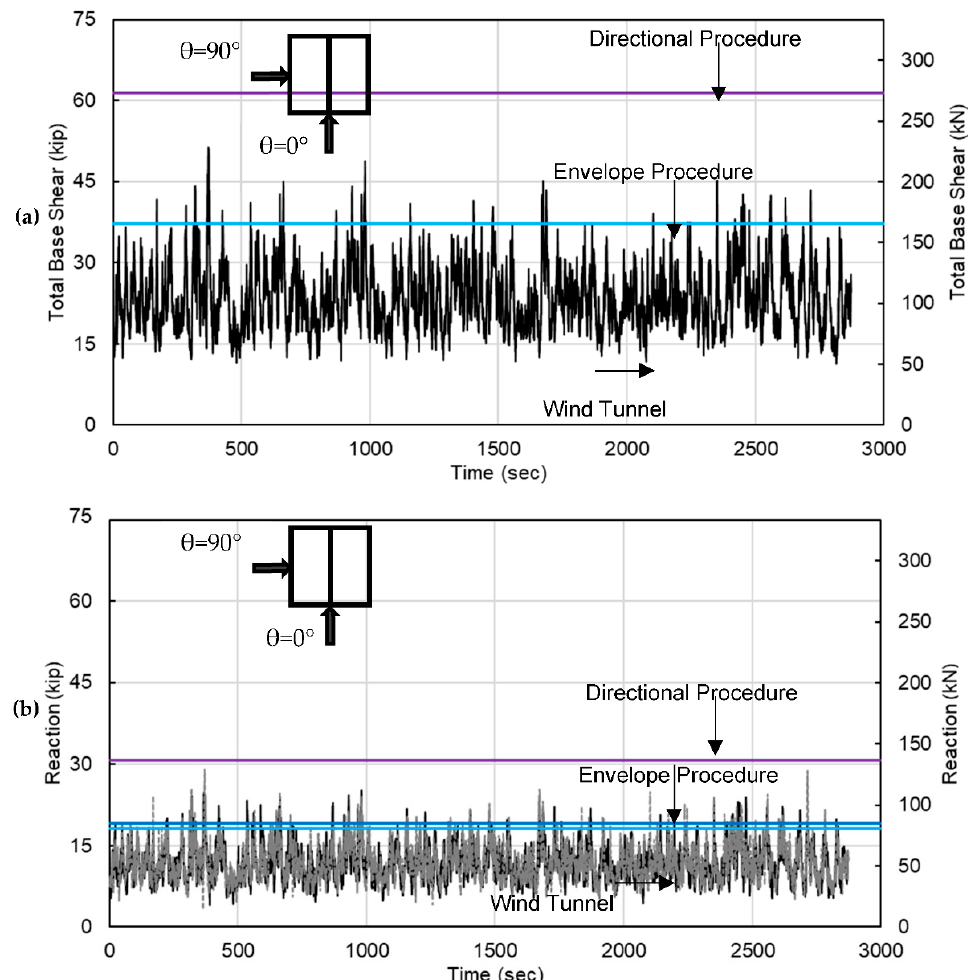
Figure 6. Load history for wind normal to ridge ( θ = 90°) for 3.7 m eave height building: ( a ) base shear, and ( b ) reaction force.